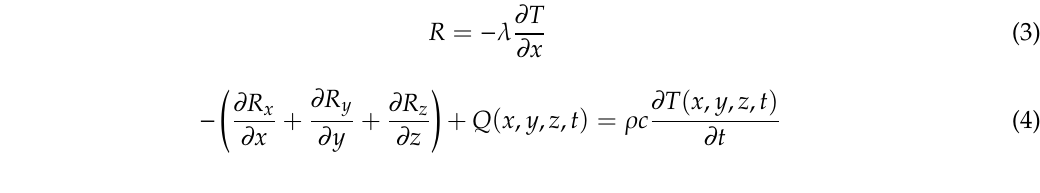
Figure 11. The temperature-dependent thermal-physical material properties of 07MnNiCrMoV, data from [23].